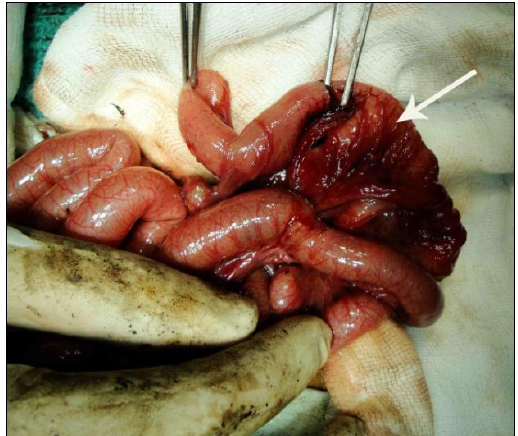
Figure 1: Perforated ileal duplication.